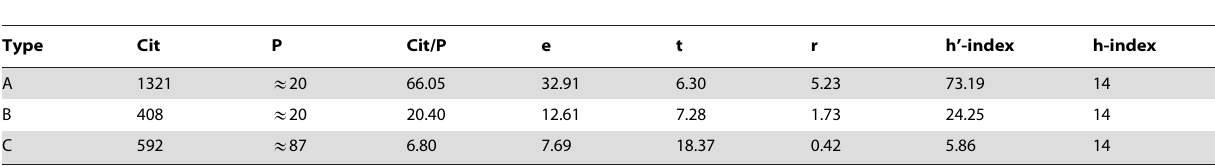
Table 1. Comparisons among three types of scientists, A, B and C in the same isohindex group with h =14 a .